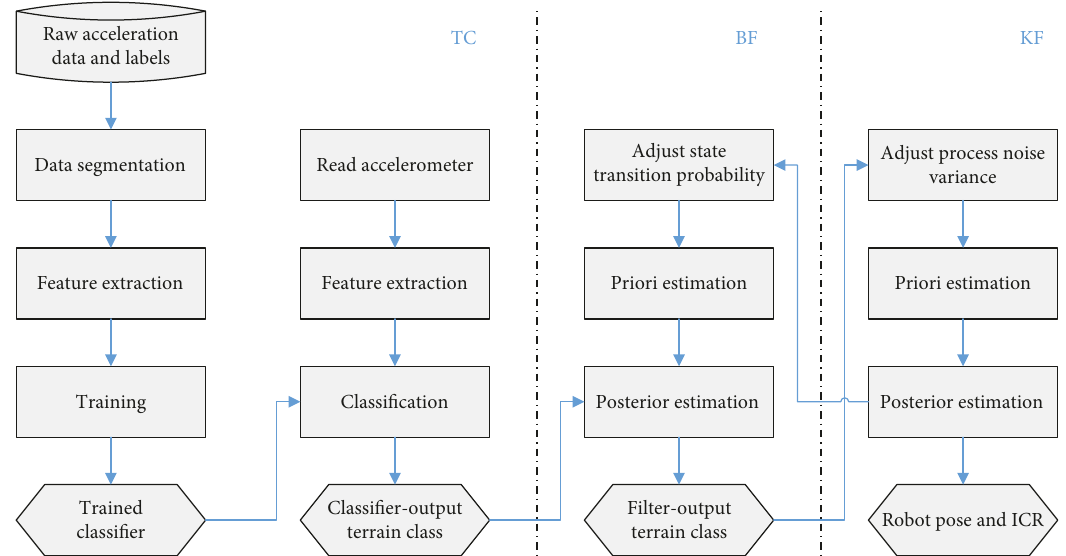
Figure 3: Schematic of the proposed terrain adaptive innovation-based extended Kalman fi lter. TC stands for terrain classi fi cation, BF stands for Bayesian fi lter, and KF stands for Kalman fi